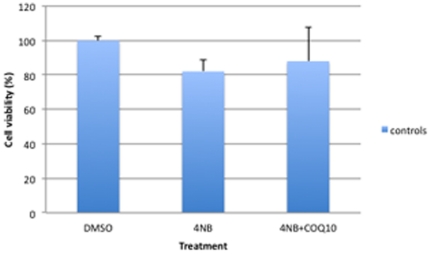
Trypan blue staining in control skin fibroblasts (n = 5) after co-treatment with 4 mM 4-NB+5 µM CoQ10.The values are expressed as percentage of the control skin fibroblasts after 4 mM DMSO. (* P<0.05 vs. controls; ** P<0.01 vs. controls).